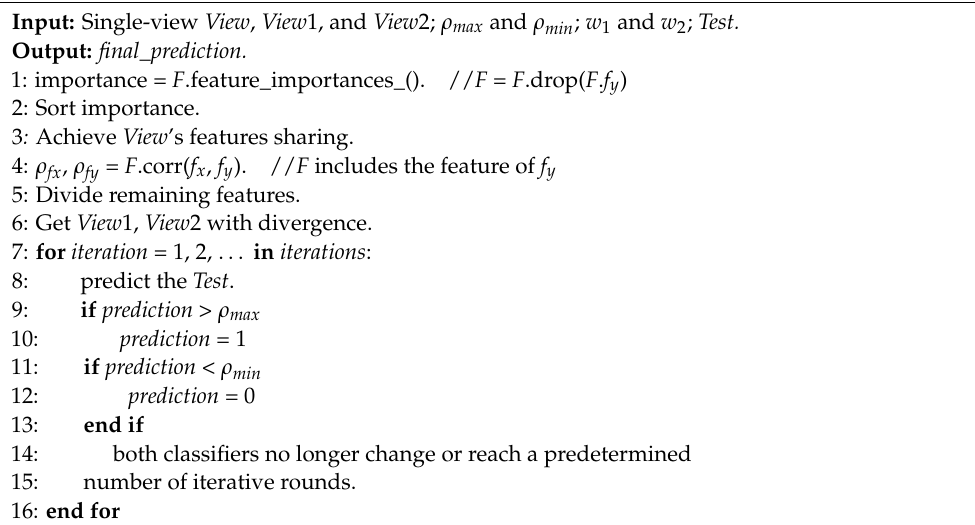
Algorithm 1: Semi-decoupled feature co-training algorithm.